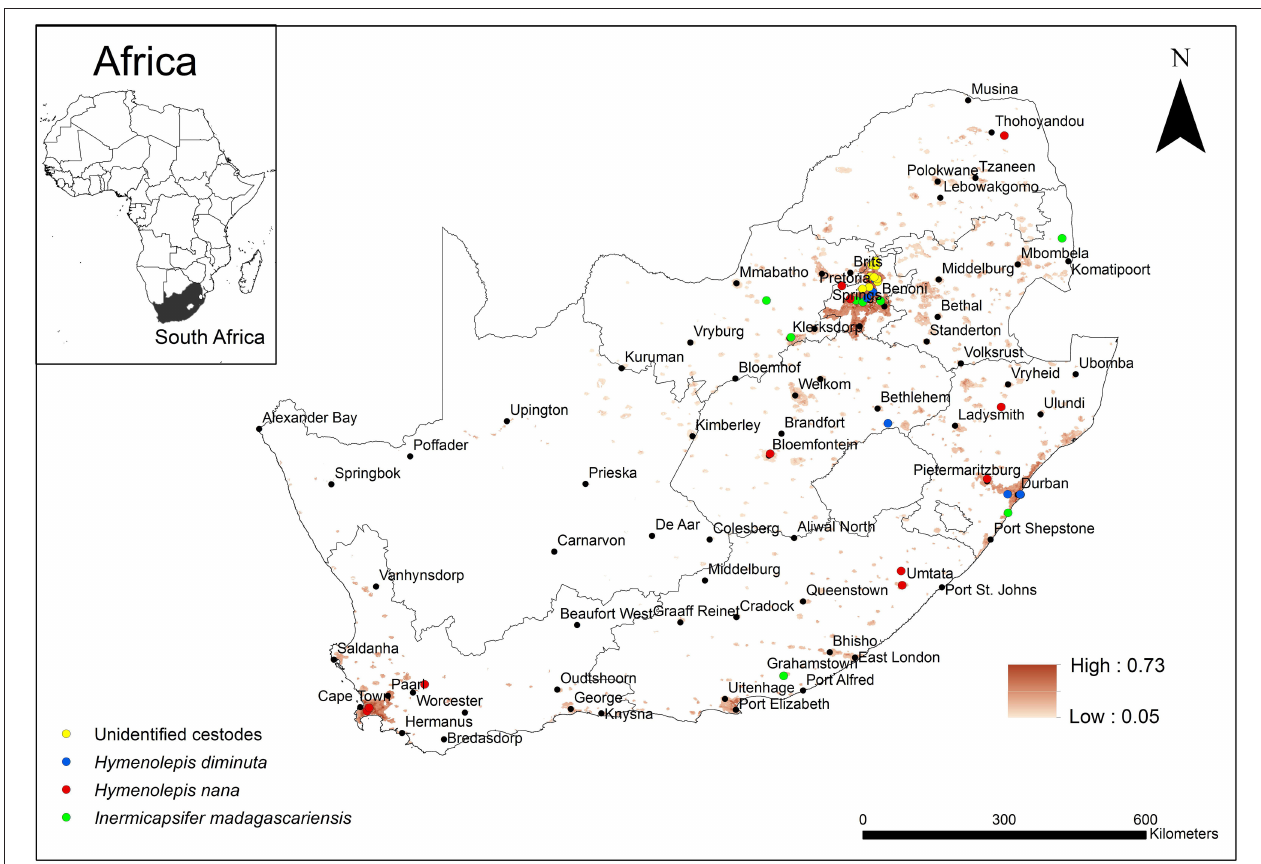
FIGURE 7 | Map showing the predicted occurrence of rodent-borne cestode taxa (weighted 25%) in South Africa based on environmental suitability (shaded areas) along with known occurrence records represented by yellow, blue, red, and green circles. White (non-shaded) areas represent areas where data were